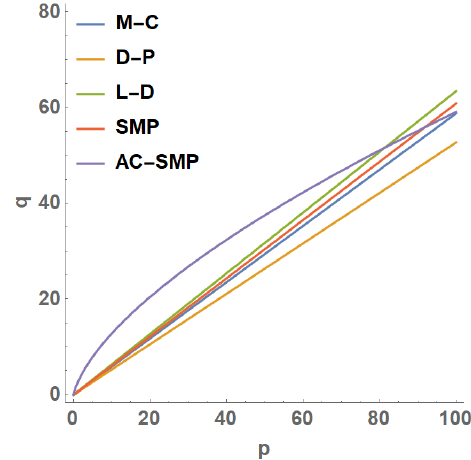
Figure 3. p-q line of each strength